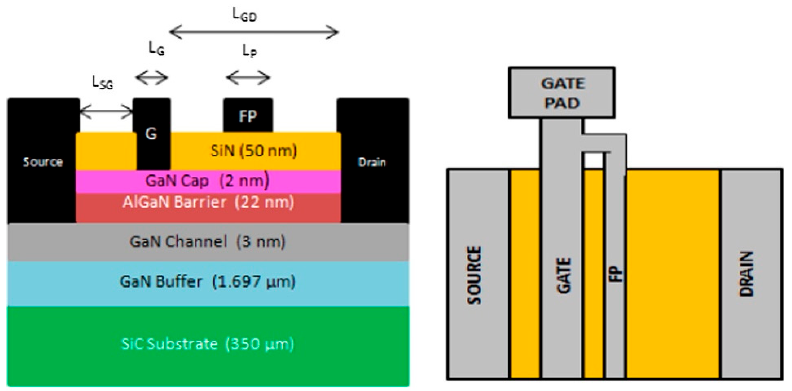
Figure 14. Cross-sectional and top views of an AlGaN/GaN HEMT structure with a discrete FP. Reprinted with permission from ref. [179]. Copyright 2019 Elsevier.